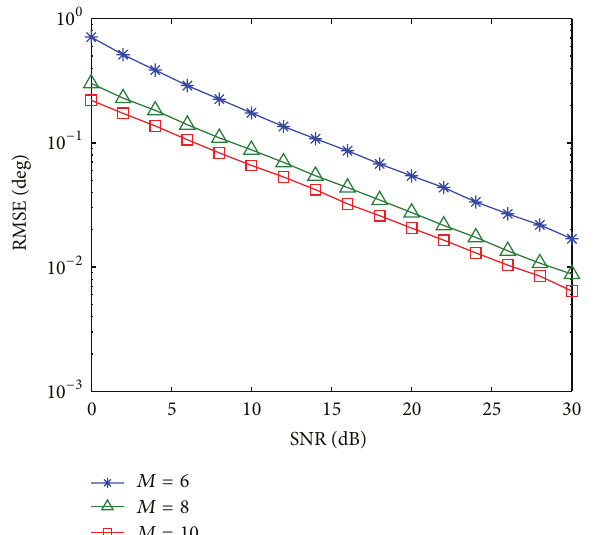
Figure 8: Total RMSE versus SNR for 3 sources with different values of 𝑀 .